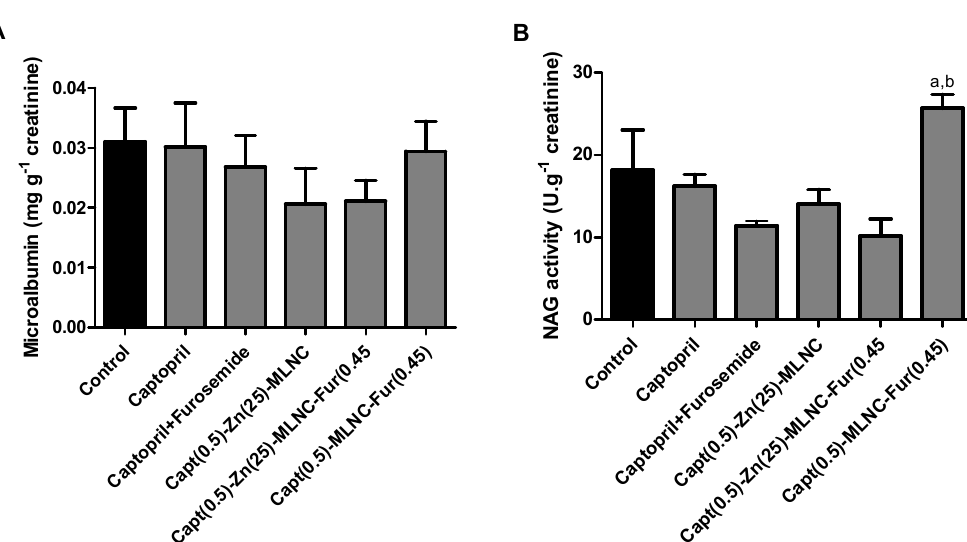
Figure 4. Microalbumin (mg g − 1 creatinine) ( A ) and N -acetyl- β - d -glucosaminidase (NAG) activity (U g − 1 creatinine) ( B ) in urine of spontaneously hypertensive rats (SHR) after 5 days of oral treatment (8 mL kg − 1 ) with solutions or formulations ( n = 6). Values are expressed as mean ± SEM. Data were analyzed by ANOVA / Bonferroni. a Significantly di ff erent from Captopril + Furosemide ( p < 0.05); b significantly di ff erent from Capt(0.5)-Zn(25)-MLNC-Fur(0.45).